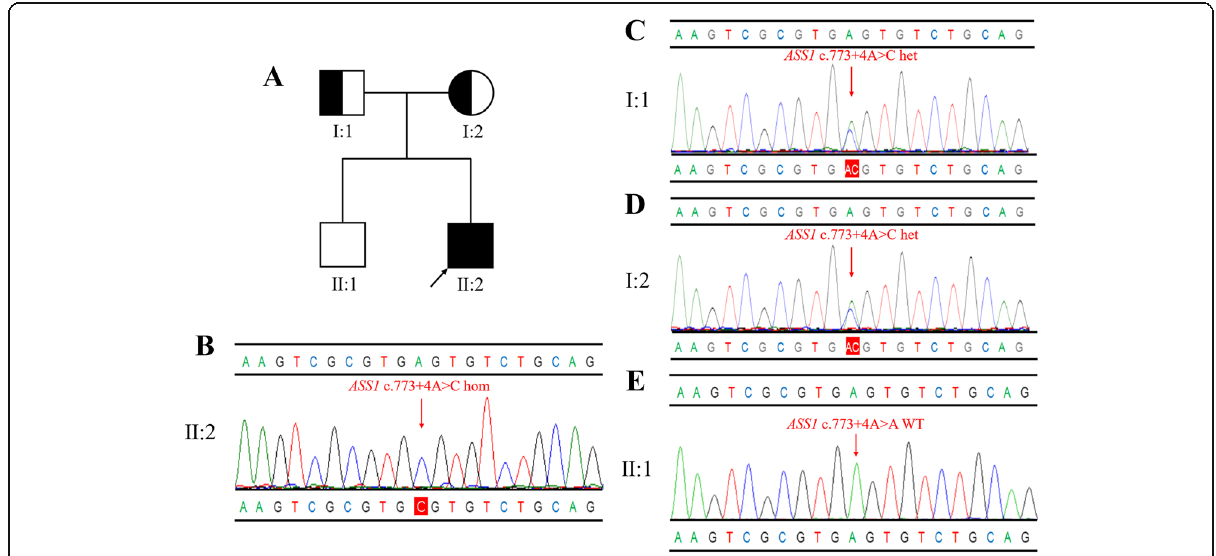
Fig. 1 a : Pedigree of the family. The filled black symbols represent the affected members and the arrow denotes the proband. b - e : Sequence analysis of the ASS1 gene independently identified the c.773 + 4A > C variant in the proband ( b ), his father ( c ), his mother ( d ), and his old brother ( e